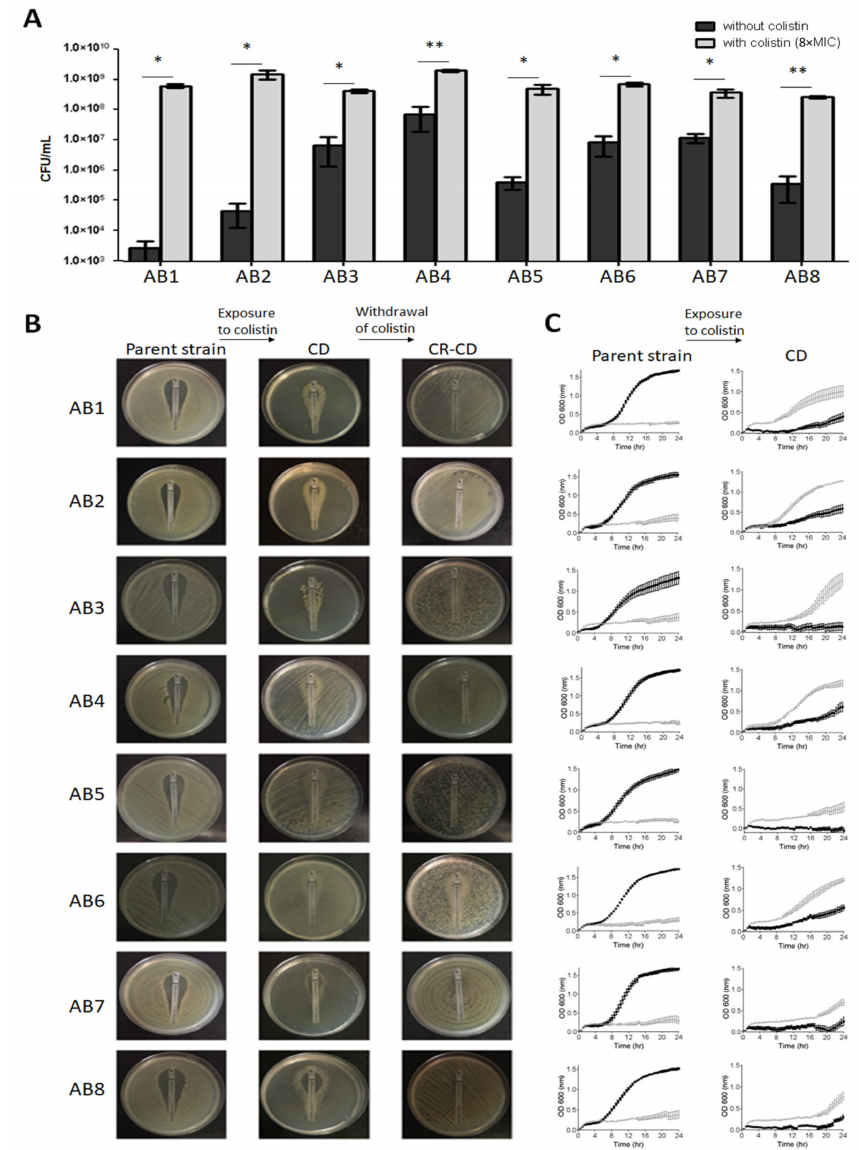
Figure 2. ( A ) Determination of CD. Final colony count (CFU/mL) of CD strains grown with and without colistin. Black bars represent the absence of colistin, and gray bars represent 8 × MIC colistin. Results are presented as mean ± SD of two independent repeats. Mean CFU/mL was significantly higher when colistin was present than when it was absent; p < 0.05 for all CD strains (* p < 0.05, ** p < 0.01), as determined by Student’s t -test. ( B ) Colistin Etest. Etest plates of parent (left), CD (middle) and CR-CD (right) strains. ( C ) Growth curves. Growth curve of parent ( left ) and CD ( right ) strains grown with and without colistin for 24 h. Black lines represent the absence of colistin, and gray lines represent 8xMIC colistin. Results are presented as mean ± SD of three independent